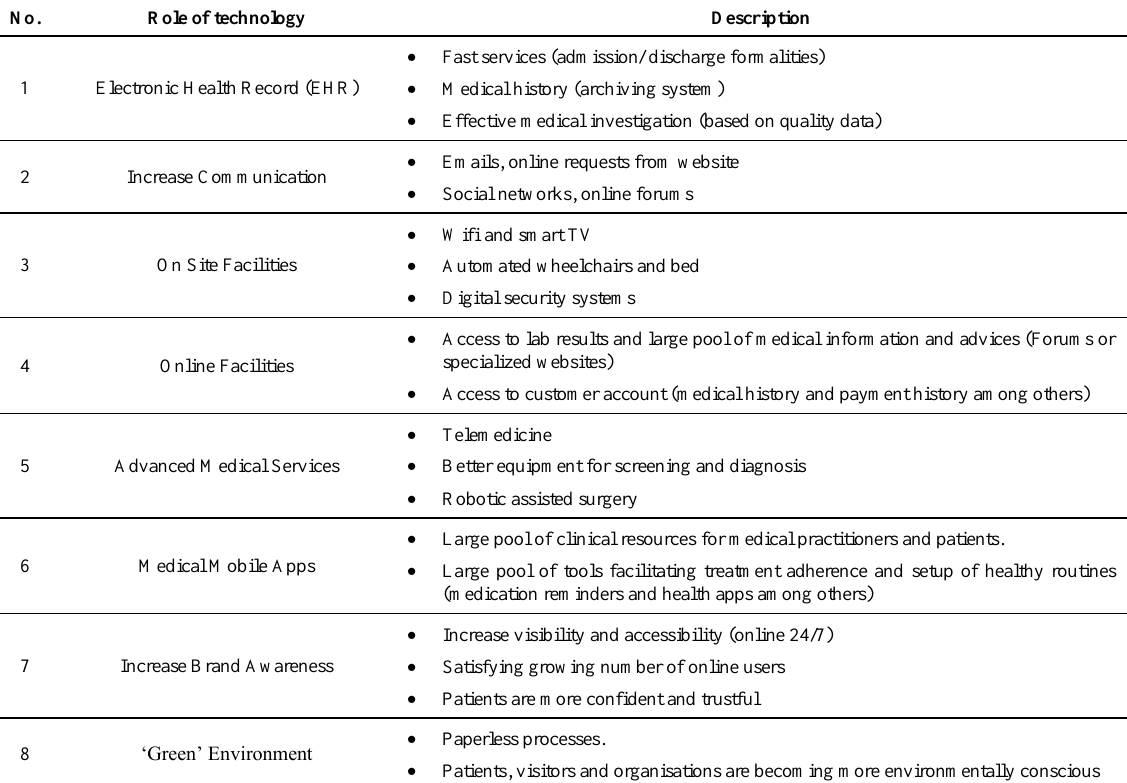
Table 1. Role of technology in healthcare